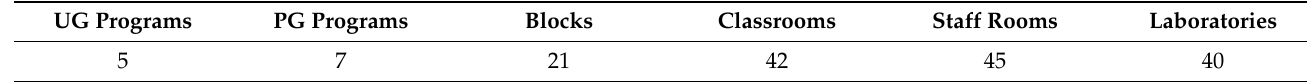
Table 1. Courses and Infrastructure details of the